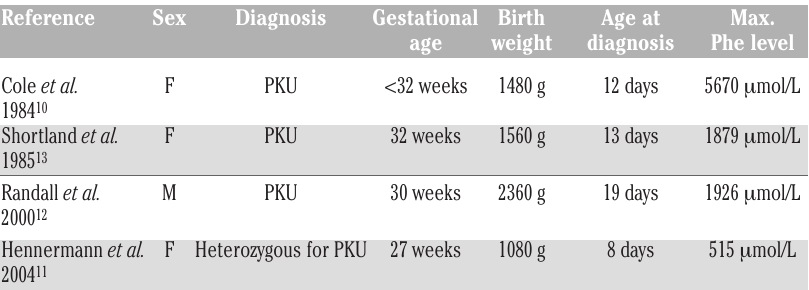
Table 3. Reported cases of premature infants with PKU. Reference Sex Diagnosis Gestational Birth Age at